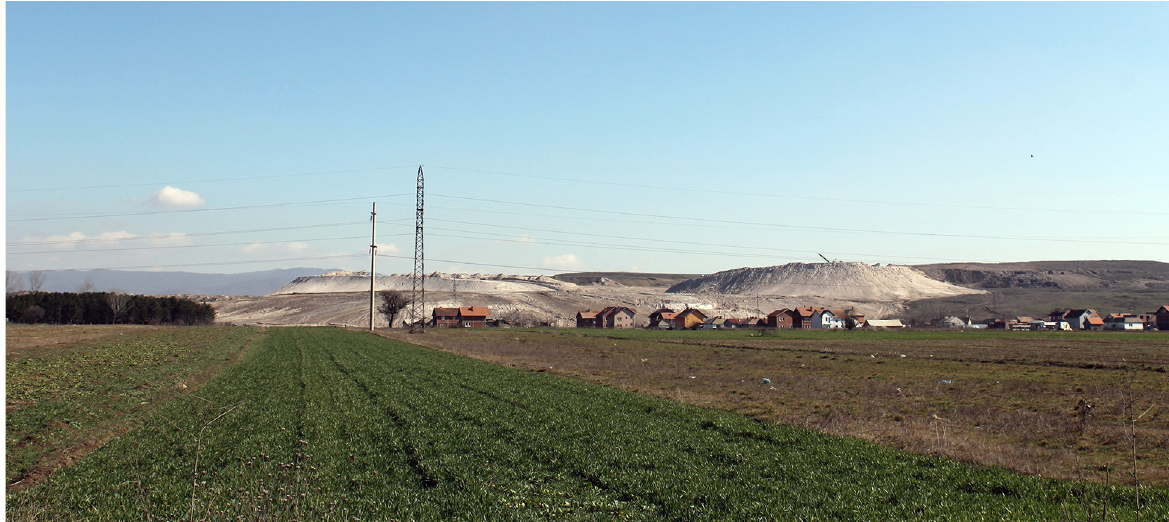
Fig. 7. Conflict between energy and agriculture. Source: V. Bytyqi.